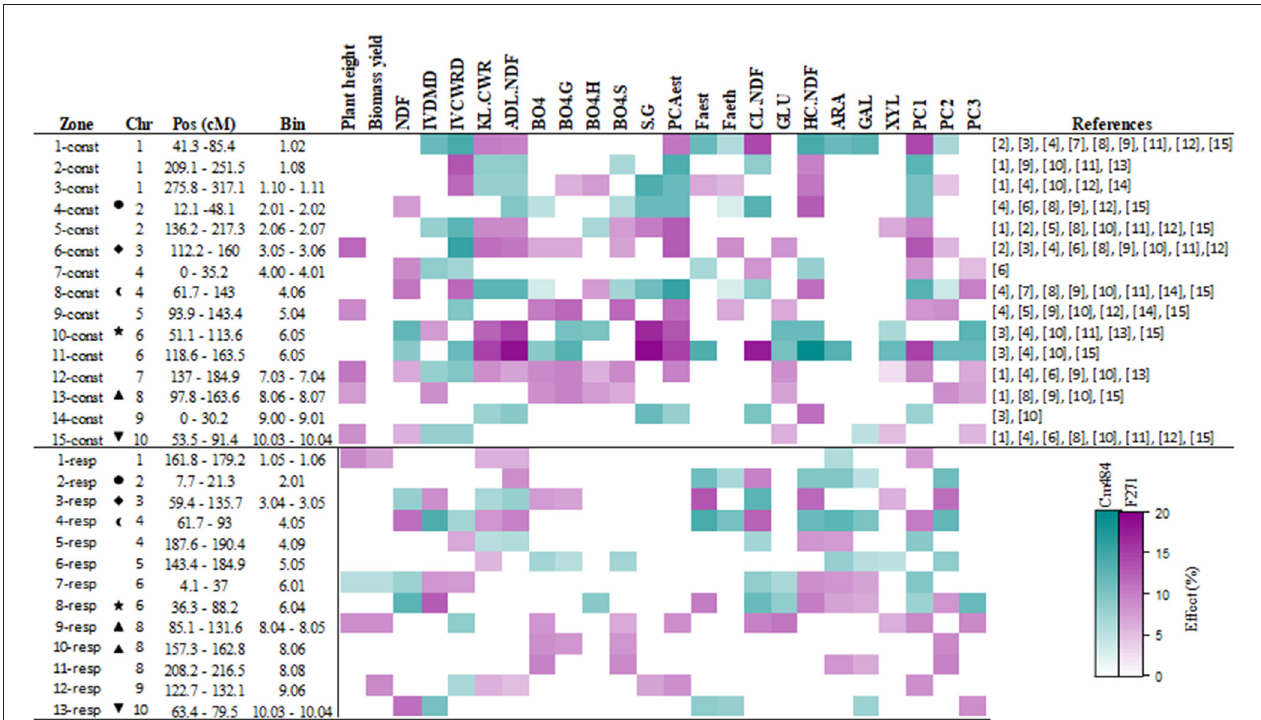
FIGURE 2 | Summary of the clusters of constitutive and responsive QTLs identified for agronomic, cell wall composition, degradability, and PCA coordinate components traits. The color corresponds to the allele increasing the traits, F271 in magenta and Cm484 in cyan. The scale of colors represented the effect at the QTL position ( Supplemental Table 2 ) over the variation of the corresponding trait on the RIL progeny lines (see materials and methods). The symbols correspond to co-localization between constitutive and responsive QTLs. The references correspond to: [1] Méchin et al., 2001; [2] Roussel et al., 2002; [3] Cardinal et al., 2003;